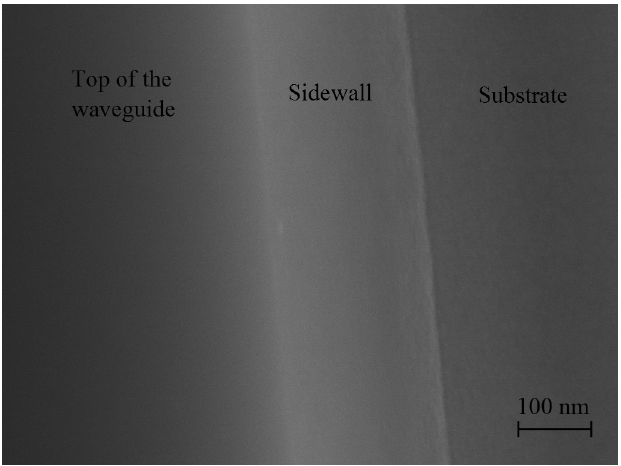
Figure 6. SEM picture, which illustrates the low sidewall roughness resulting from an optimized etching